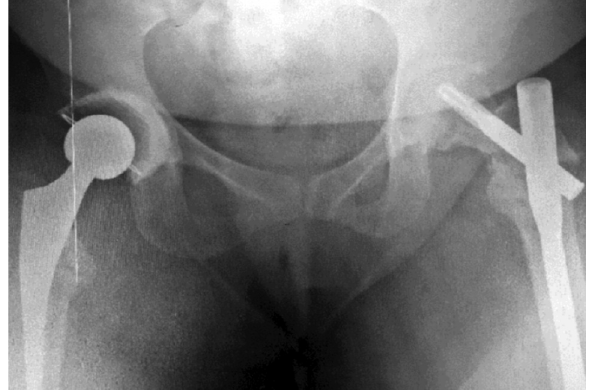
Pelvis AP radiograph showing right total hip arthroplasty Fig. 2: and left proximal femoral